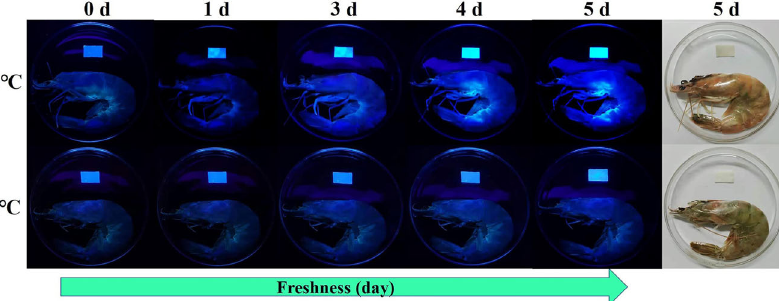
Fig. 4 Fluorescence images of the self-healable polyurethane fi lms applicable to shrimp packaging. The fl uorescence of the fi lms enables real-time monitoring of the freshness of shrimps stored at different temperatures. Reproduced from 79 with permission from Elsevier